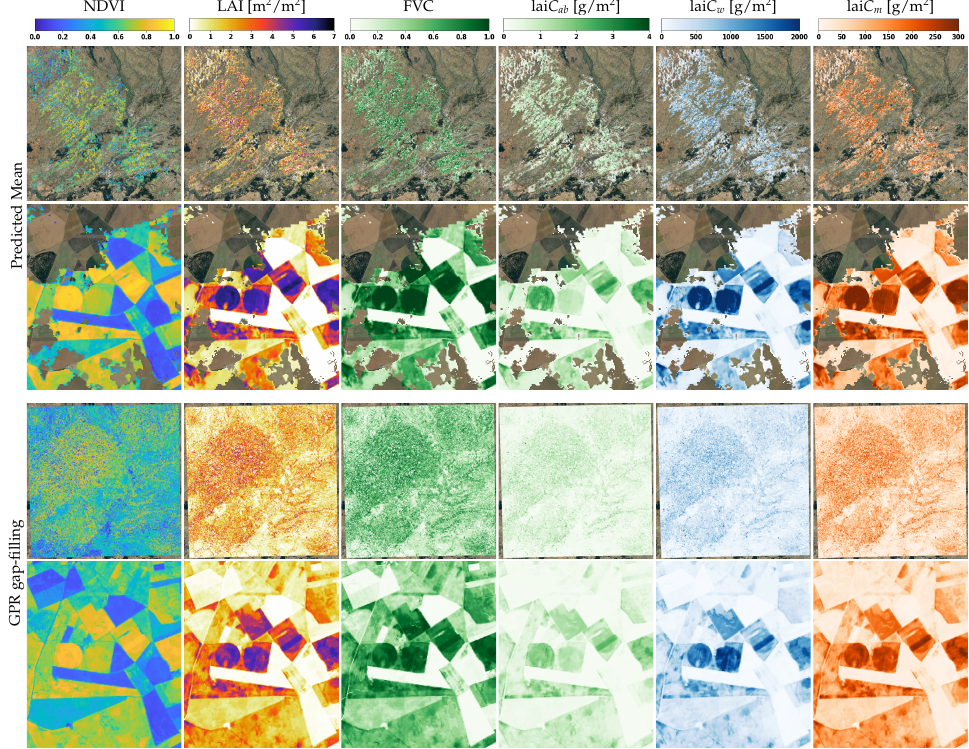
Figure 6. Predicted mean values of NDVI and crop traits for a cloud-gapped tile 30TUM on April 11,2020 (Castile and Leon, Spain) and zoom-in of the study site. Underneath the same maps are shown after GPR gap-filling. See Figure 2 for the geo-information.